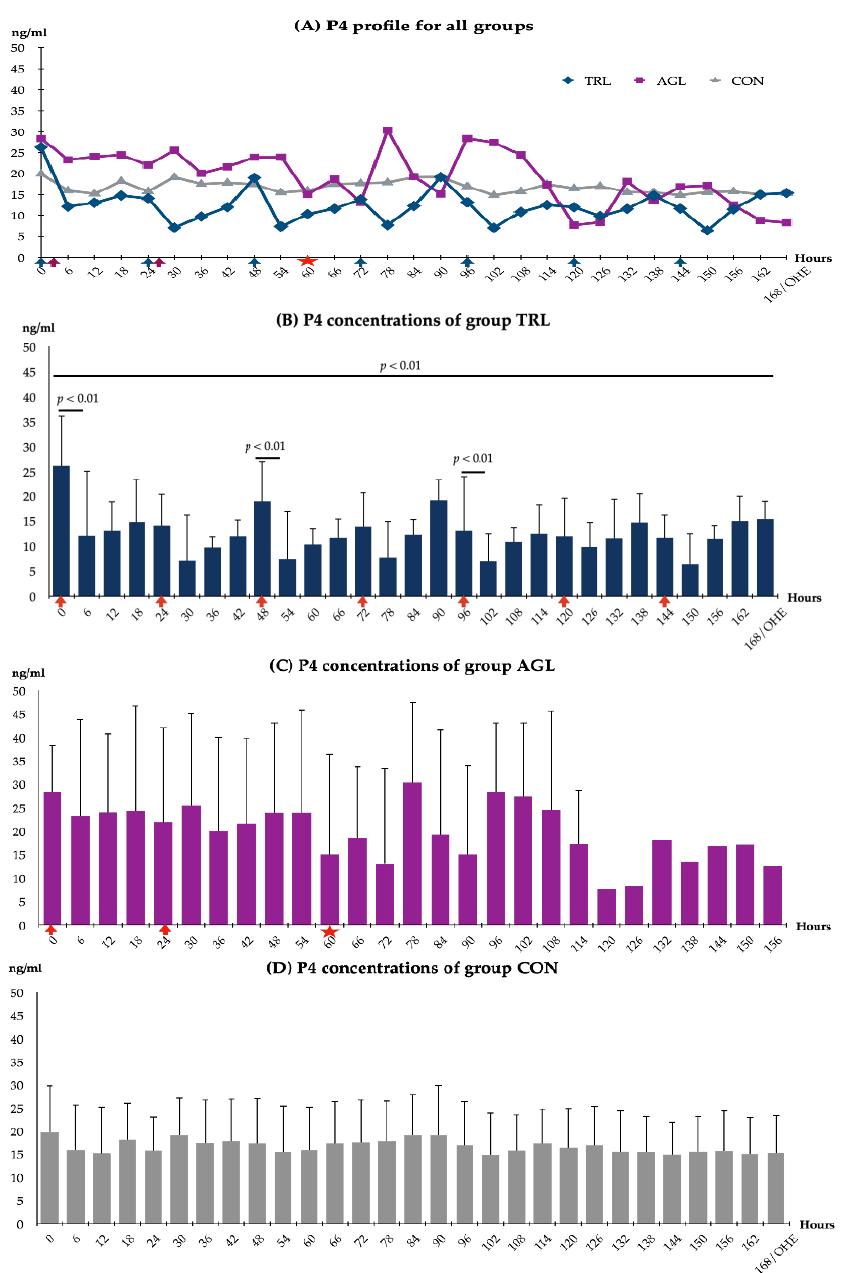
Figure 4. Serum P4 profiles for all groups. TRL: trilostane; AGL: aglepristone; CON: control. ( A ) and P4 concentrations for each of the groups ( B – D ). TRL and AGL treatment time indicated by dark blue and purple arrows ( A ) and red arrows ( B , C ). The red star marks the start of PT in the AGL group in subfigures ( A , C ). Statistical analysis was not performed in the AGL group, as the number of animals decreased after 60 h due to PT ( C ).